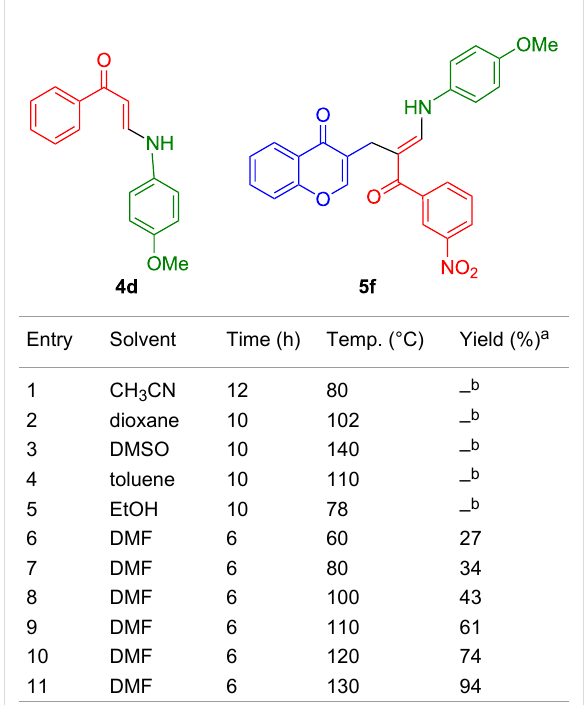
Table 1: Solvent screen and temperature optimization for the syn- thesis of compound 5f